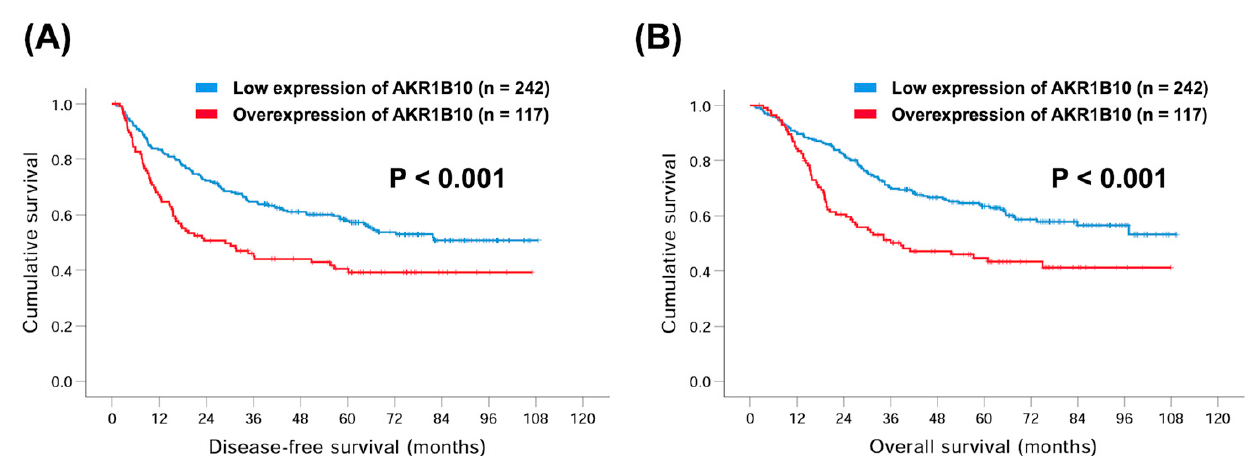
Figure 2. Kaplan–Meier curves comparing 5-year disease-free survival (DFS) and overall survival (OS) rates in GC patients with overexpression or low expression of AKR1B10. ( A ) DFS; ( B ) OS. For OS, the differences in age, sex, and tumor grade between the two groups were not significant. Based on the univariate analysis, patients with pathological T3–T4 (compared to pathological T1–T2, 40.2% versus 79.4%, p < 0.001), pathological N1–N3 (compared to pathological N0, 40.3% versus 76.5%, p < 0.001), pathological stage III (compared